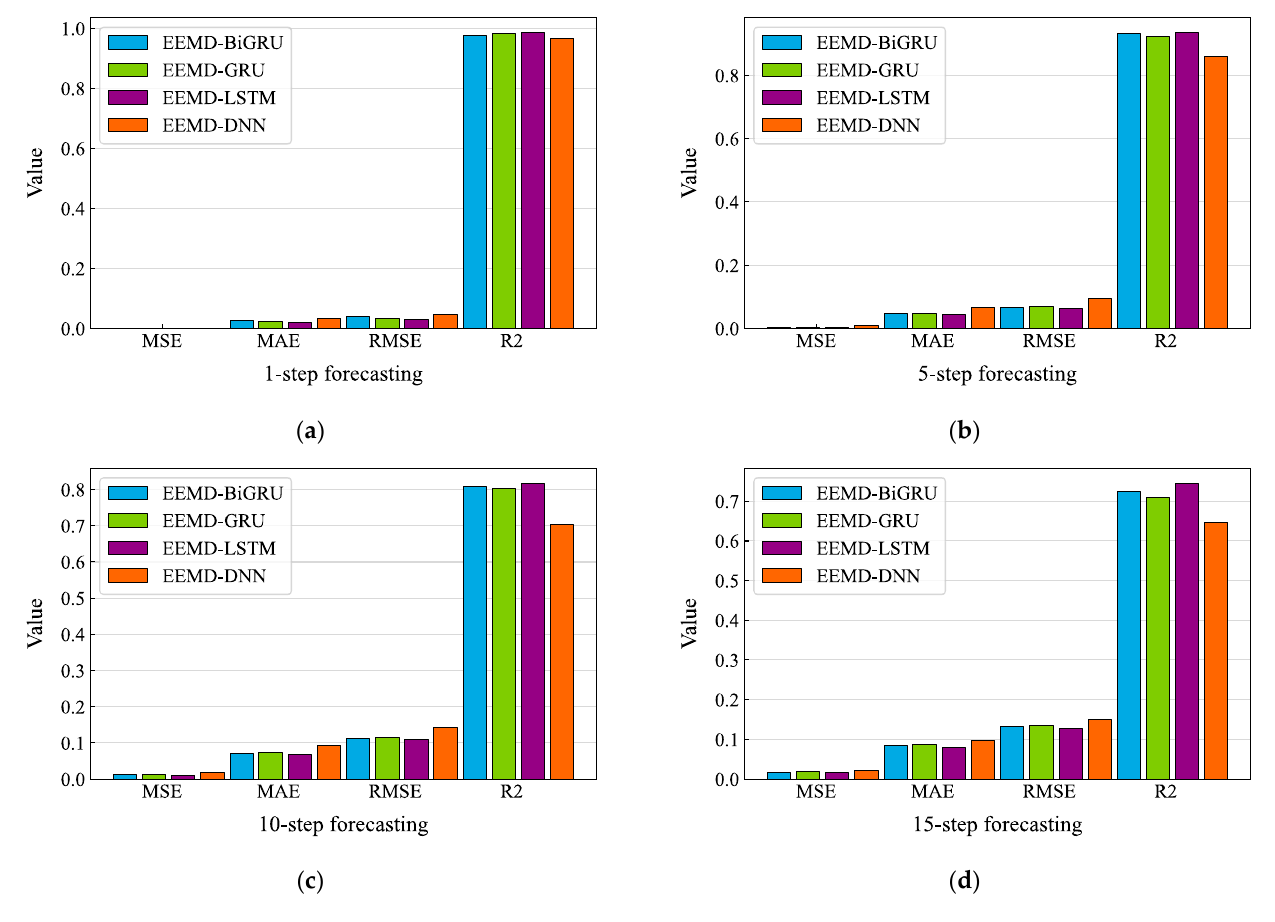
Figure A4. Evaluation metric comparison results for the RG dataset using the EEMD-based algo- rithms: ( a ) 1-step forecasting of the four hybrid models; ( b ) 5-step forecasting of the four hybrid models; ( c ) 10-step forecasting of the four hybrid models; ( d ) 15-step forecasting of the four hybrid models.